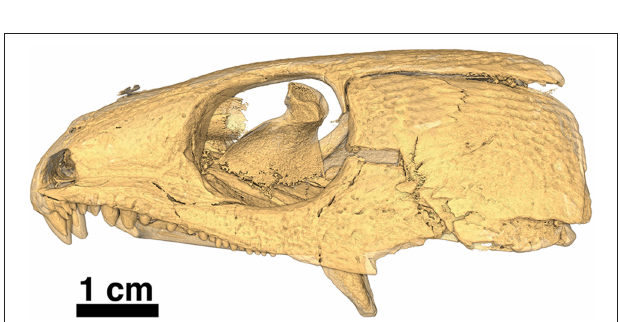
FIGURE 12 | Isomorphic rendering of a neutron scan of the holotype of Captorhinus kierani in left lateral view. Note the absence of the lower jaw, which is part of a separate block containing the anamniote Acheloma (see Figure 2 ). The transverse process of the pterygoid can be seen extending ventrally, well below the tooth